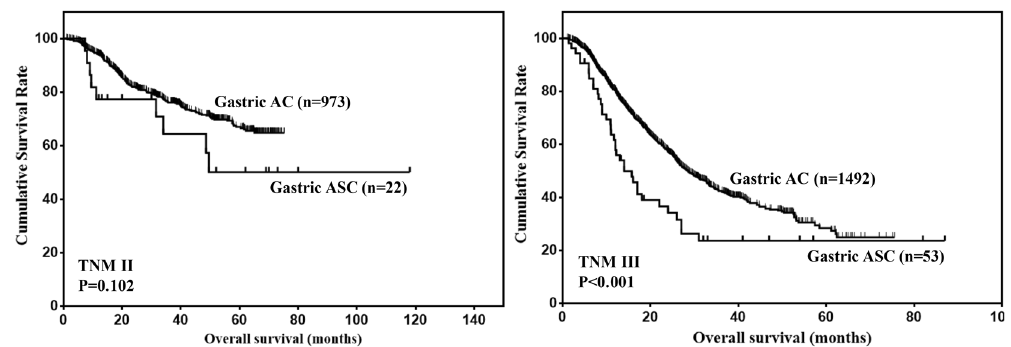
Figure 3. Comparison of OS between gastric ASC and AC in stage II/III